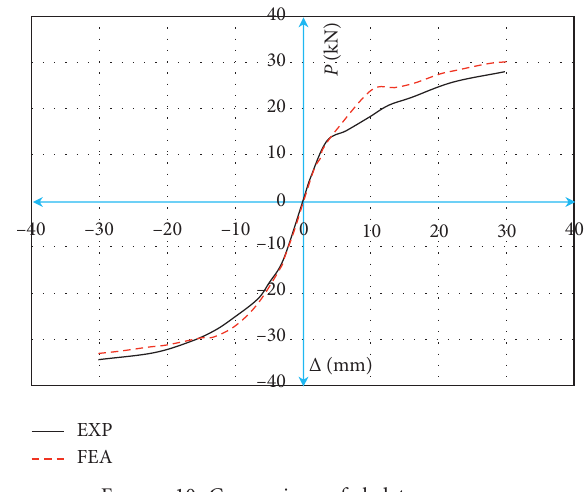
Figure 10: Comparison of skeleton